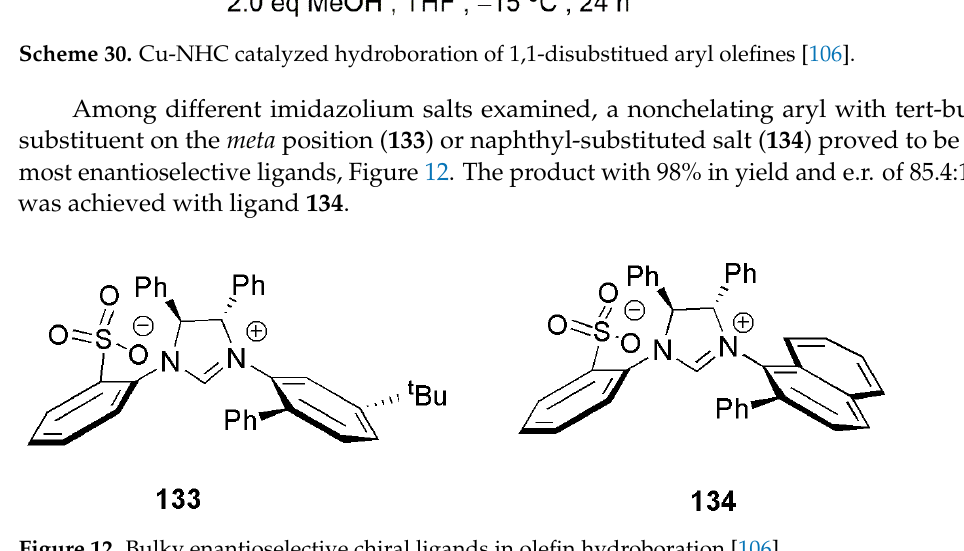
Figure 12. Bulky enantioselective chiral ligands in olefin hydroboration [106].